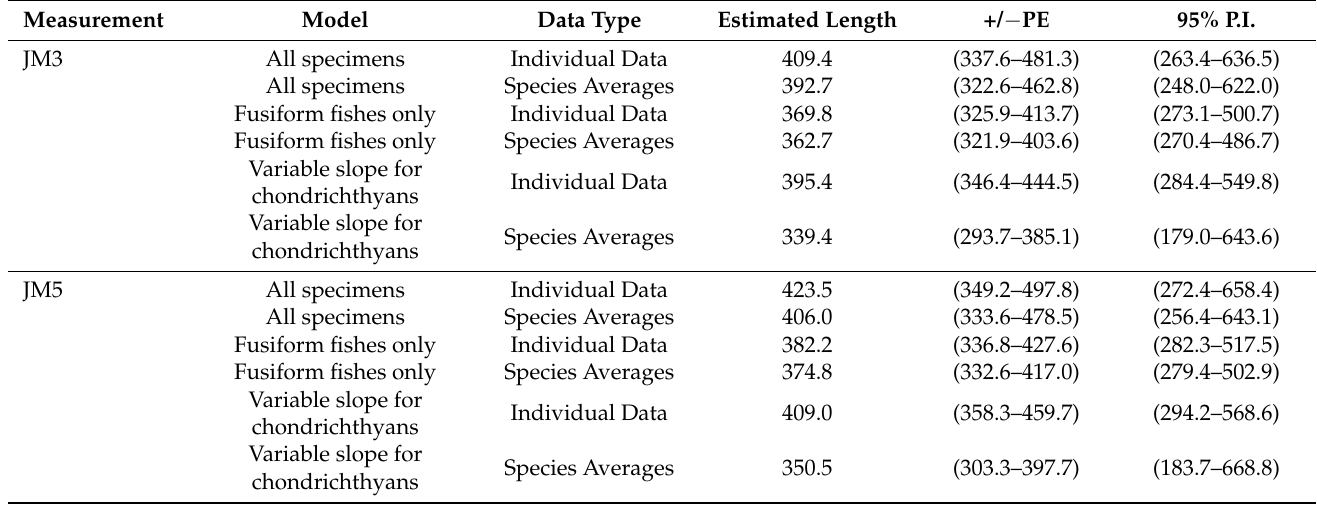
Table 4. Estimated lengths (in cm) of the largest known specimen of Dunkleosteus terrelli (CMNH 5936) using the best-performing models in this study. Abbreviations as in Table 2. All measurements in